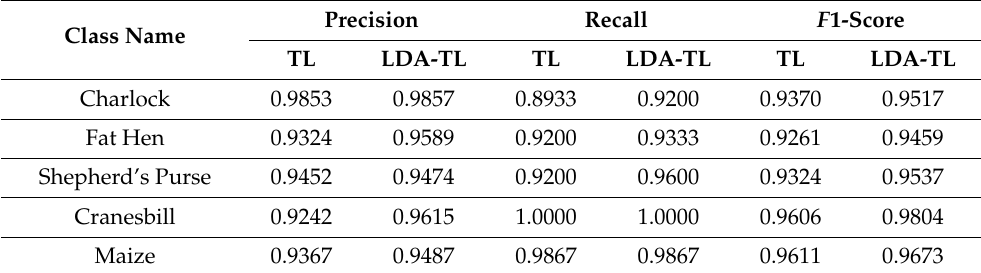
Table 5. Analysis of classification results of LDA on deep features of AlexNet . The LDA and GAN- LDA refer to the LDA models trained with the real image data, and combined real and artificial datasets,